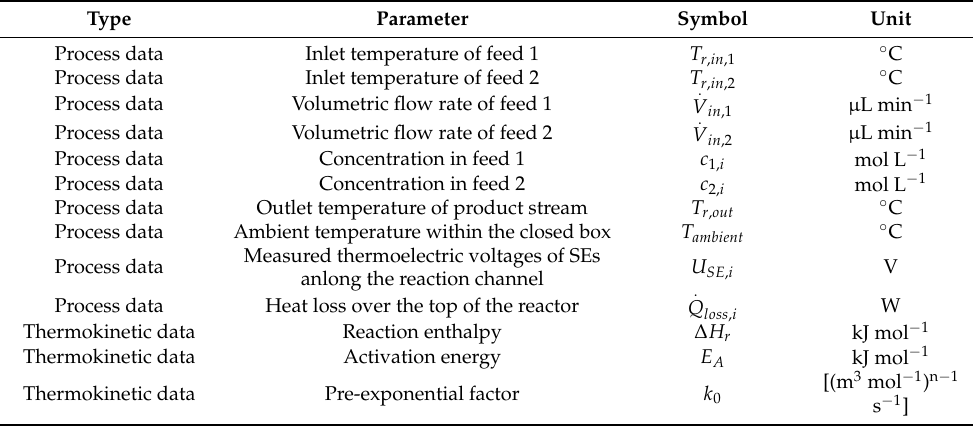
Table 1. Process data measured by microscale flow reaction calorimeter and thermokinetic data determined via calorimetric measurement